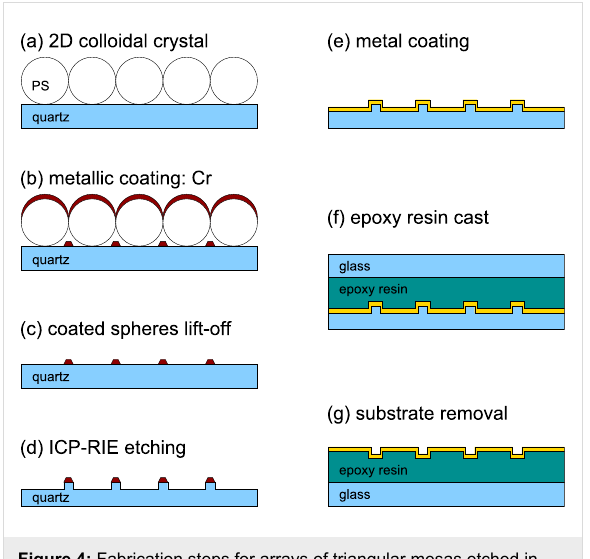
Figure 4: Fabrication steps for arrays of triangular mesas etched in quartz and arrays of holes in metal films, prepared by casting with epoxy resin: (a) Preparation of 2D colloidal crystal; (b) Cr coating; (c) PS spheres lift-off; (d) RIE; (e) metal coating (PVD) (f) epoxy resin cast; (g) substrate